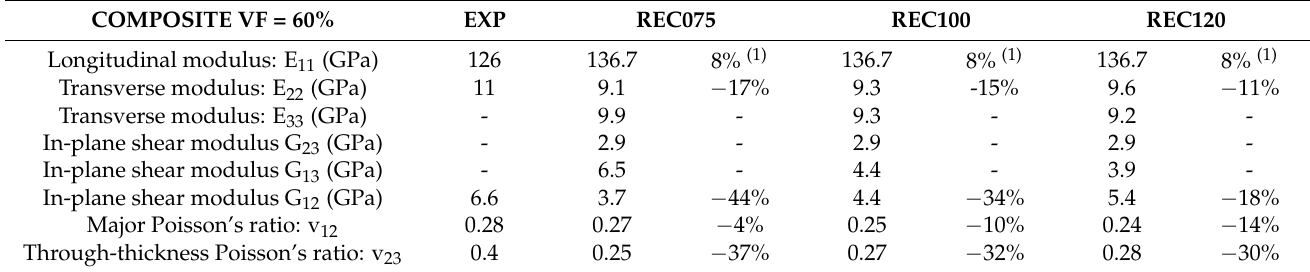
Table 6. Comparisons between the measured experimental (EXP) and the predicted effective proper- ties for RECTANGLE RUCs at various aspect ratios.